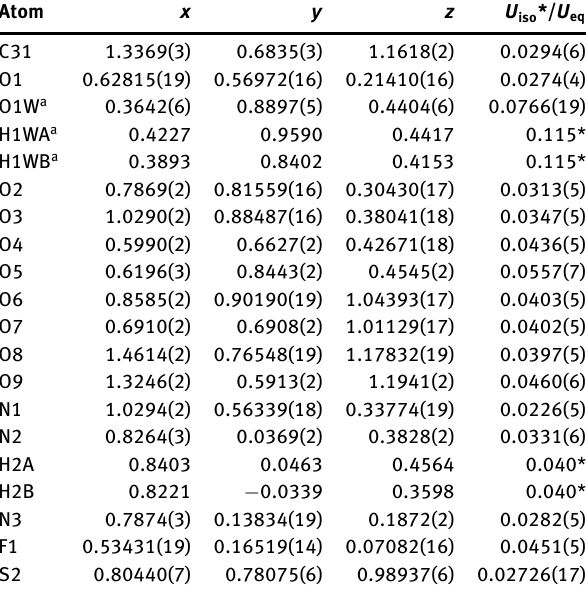
Table 2: Fractional atomic coordinates and isotropic or equivalent isotropic displacement parameters (Å 2